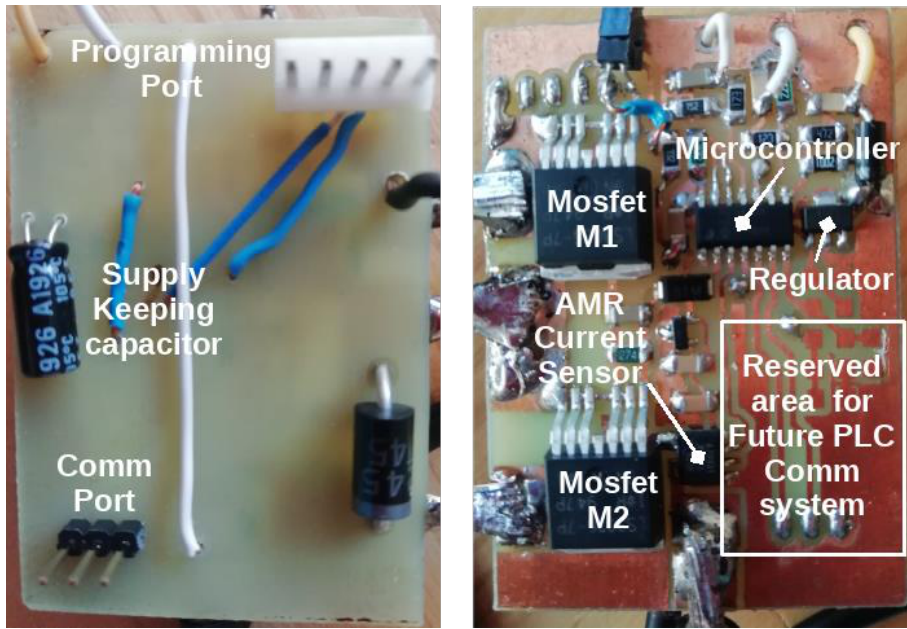
Figure 6. Picture of the electronic board installed in PV modules for the distributed